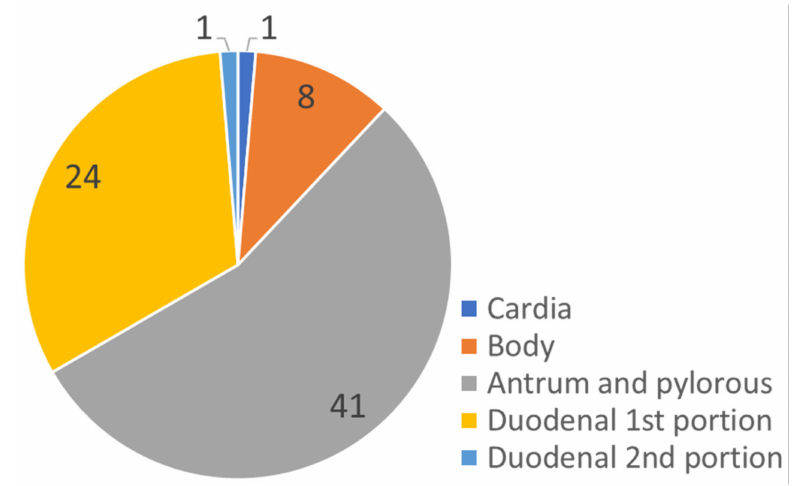
Figure 1. Anatomical location of the perforated peptic ulcer. Table 2. Clinical characteristics according to surgical complication